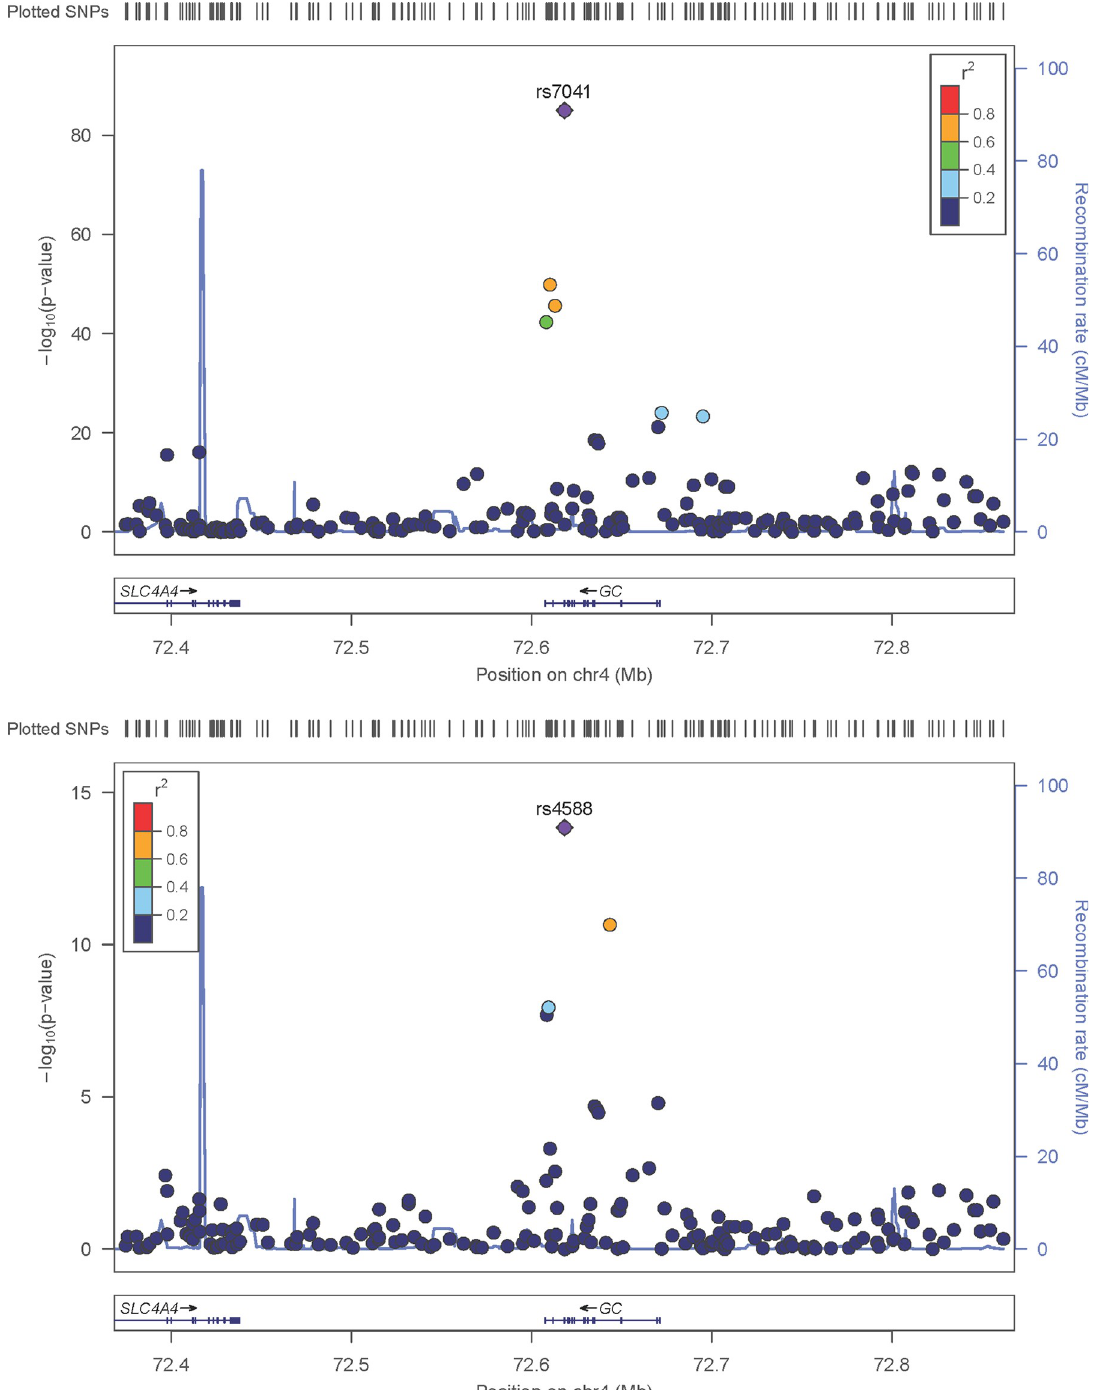
Fig 2. Regional association plots for variants associated at genome-wide significance (P < 5.0x10 -8 ) with VDBP in the AA-DHS cohort. The -log10 (p-value) is shown on the left y-axis, recombination rates [expressed in centiMorgans (cM) per Mb; NCBI Build GRCh37; highlighted in blue] are shown on the right y-axis and position in Mb is on the x-axis. Pairwise linkage disequilibrium (r 2 ) of each variant with the top variant in the region is indicated by its color. A. rs7041 (VDBP) and B. rs4588 (VDBP, adjusted for rs7041).